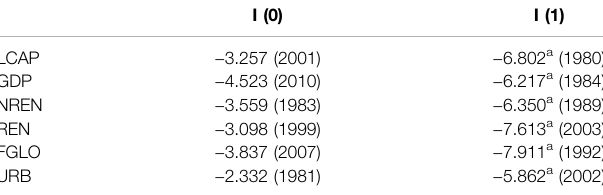
TABLE 3 | Structural break unit-roots outcome.